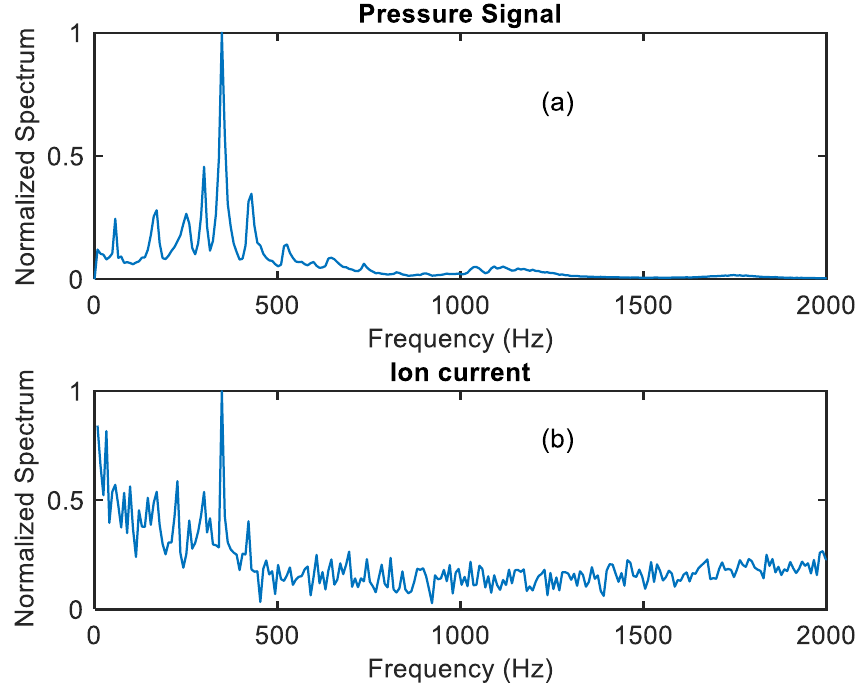
Figure 16. Spectra of the pressure (plot ( a )) and of the ionic current (plot ( b )) signals during a Fig. 16 grid off combustion chamber pulsation event at 348 Hz (arbitrary